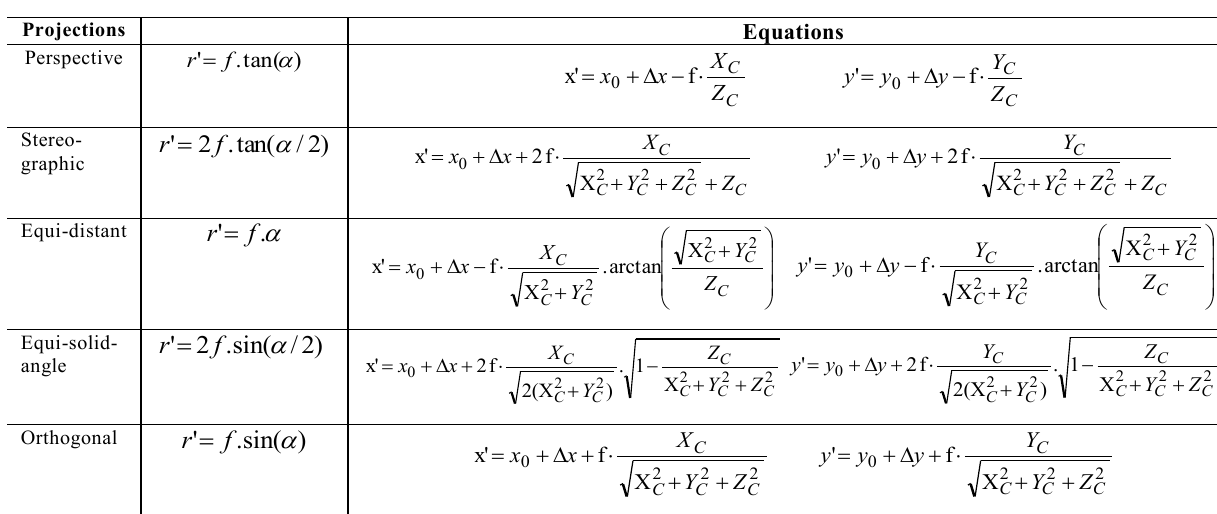
This contribution has been peer-reviewed.